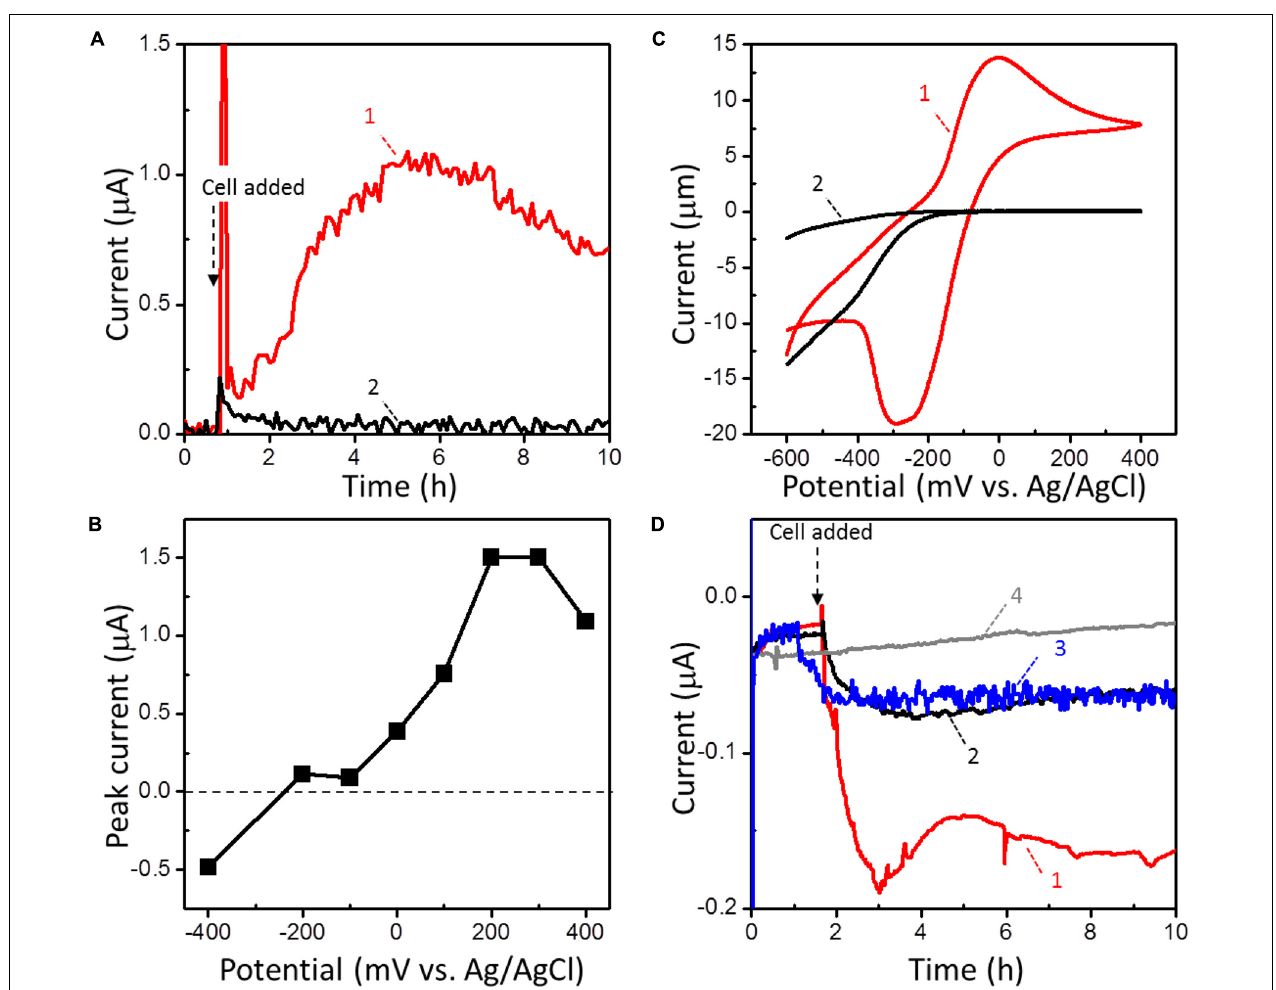
FIGURE 2 | (A) Current ( I ) vs. time ( t ) measurements of microbial anodic current generation for intact (trace 1) and heat-killed (trace 2) strain 110S on an FTO electrode at +200 (mv vs. Ag/AgCl sat. KCl). Cell density was adjusted to OD 600 = 1. (B) The potential dependence of the peak current for the microbial anodic current generation by strain 110S. (C) Whole-cell CVs (scan rate 1 mV/s) in the presence (trace 1) and absence (trace 2) of strain 110S cells. Cell density was adjusted to OD 600 = 10. The cathodic current observed for the reactor without cells (trace 2) is not due to the reduction of oxygen, but likely attributable to the substrates present in Marine Broth 2216. (D) I vs. t measurements of microbial cathodic current generation by strain 110S on an FTO electrode at –100 mV. I vs. t curves was measured in the presence (trace 1) and absence (trace 2) of nitrate (5 mM) as an electron acceptor. Cell density was adjusted to OD 600 = 2. Trace 3 is the current generation by heat-killed cells. The back ground current measured without any inoculation was also shown in trace